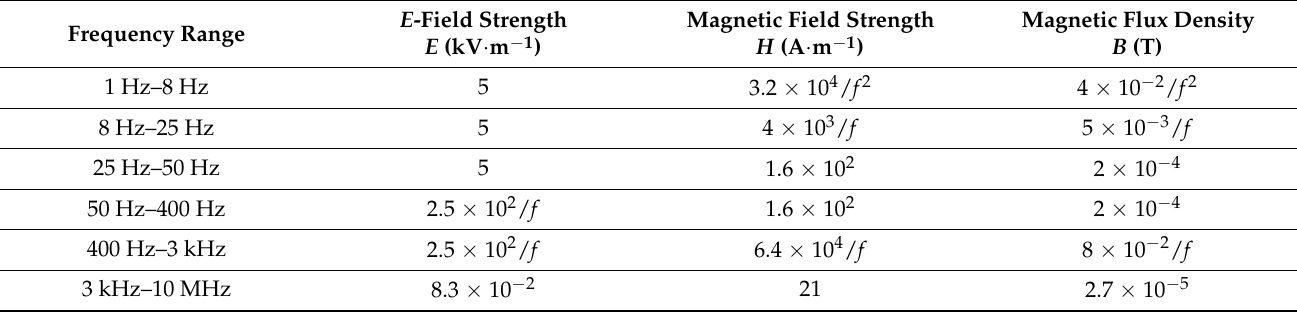
Table 2. Reference levels for general public exposure to time varying electric and magnetic fields. Reprinted from ref. [70].